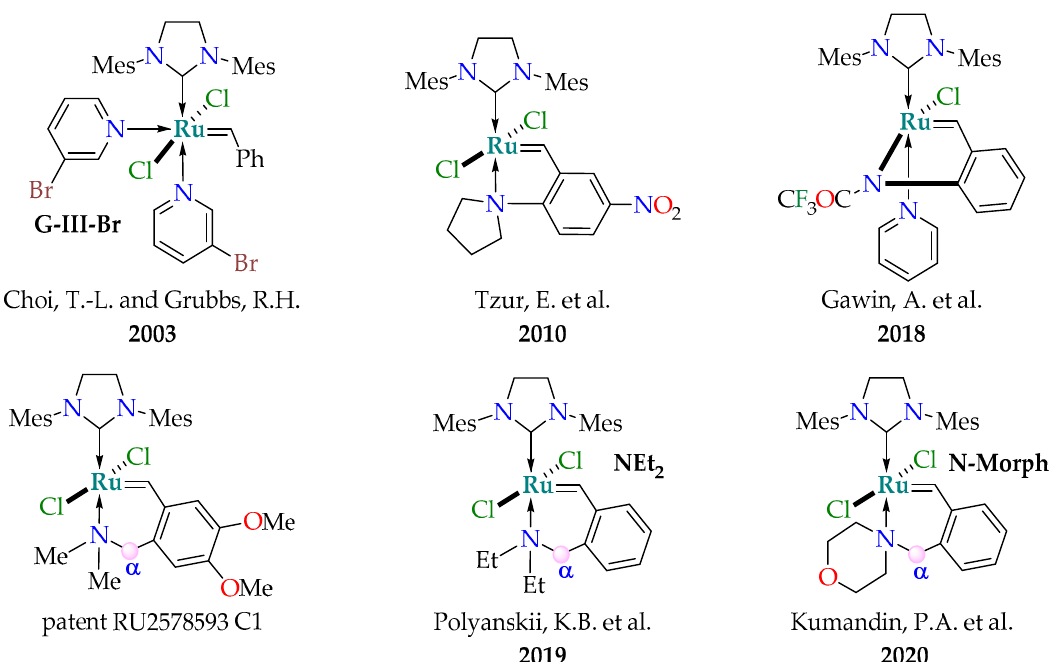
Figure 1. N–Ru complexes that are closest to this study (the top row [8,37,38], the bottom row